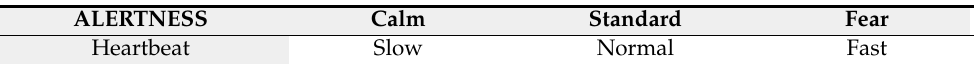
Table 6. Table of rules ALERTNESS/Heartbeat. The gray cells represent the different ALERTNESS labels and the Heartbeat